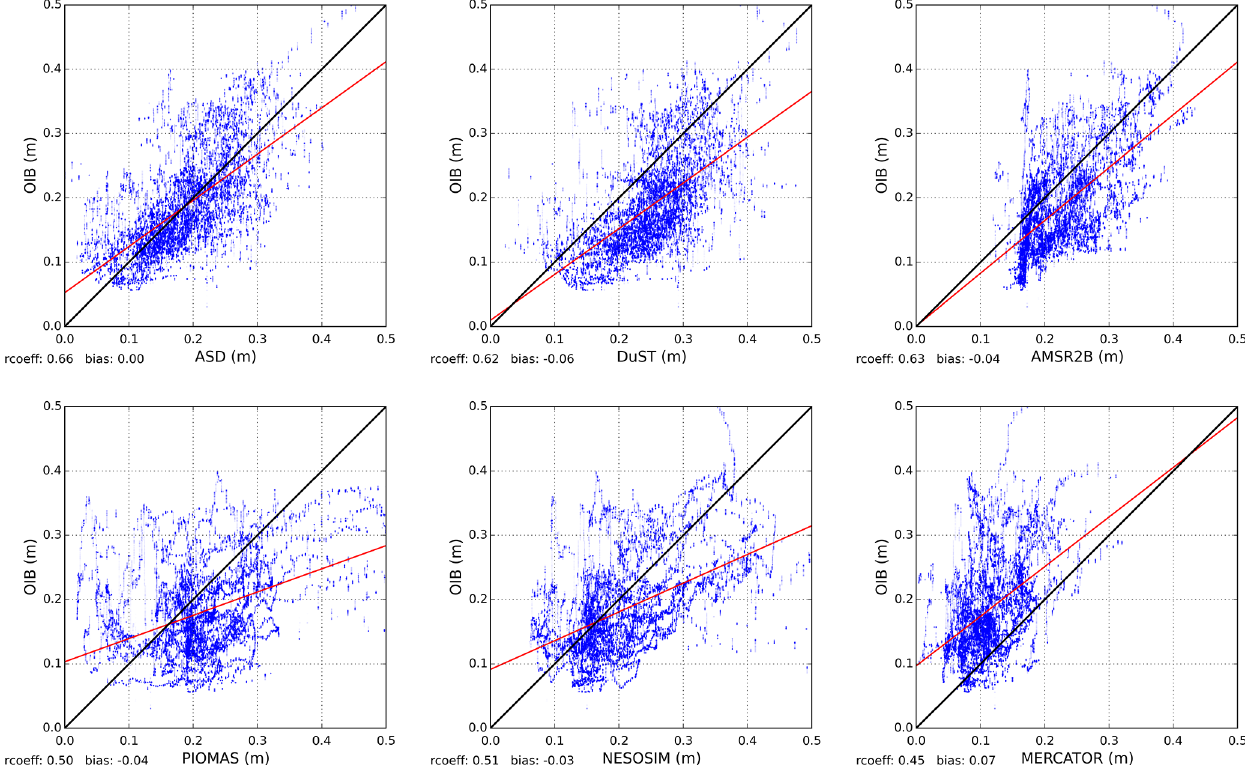
Figure 7. Scatter plots between the snow depth products and OIB snow radar data considering the 2014 to 2018 missions. The red line is the linear fitting line. For NESOSIM, 2018 is not included. Table 1. Statistics of the comparison between OIB snow radar data and the various snow depth products considering the OIB spring cam- paigns of